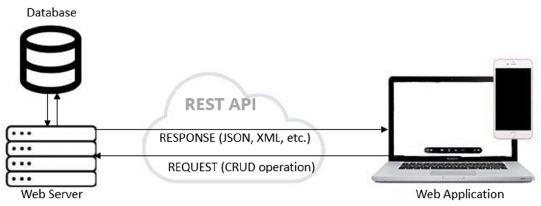
Figure 1. Applicability of REST API.